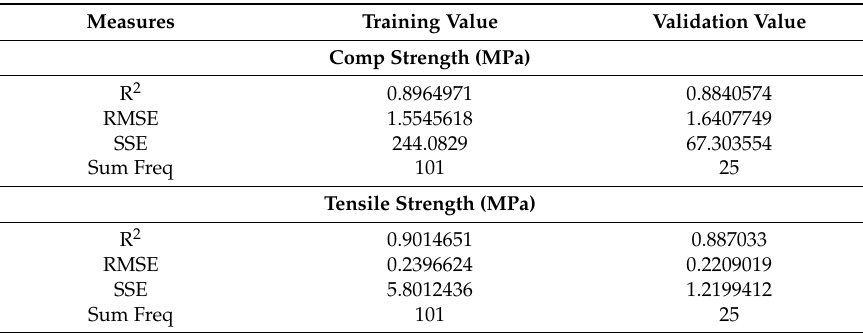
Table 8. Model parameter estimates for training and validation